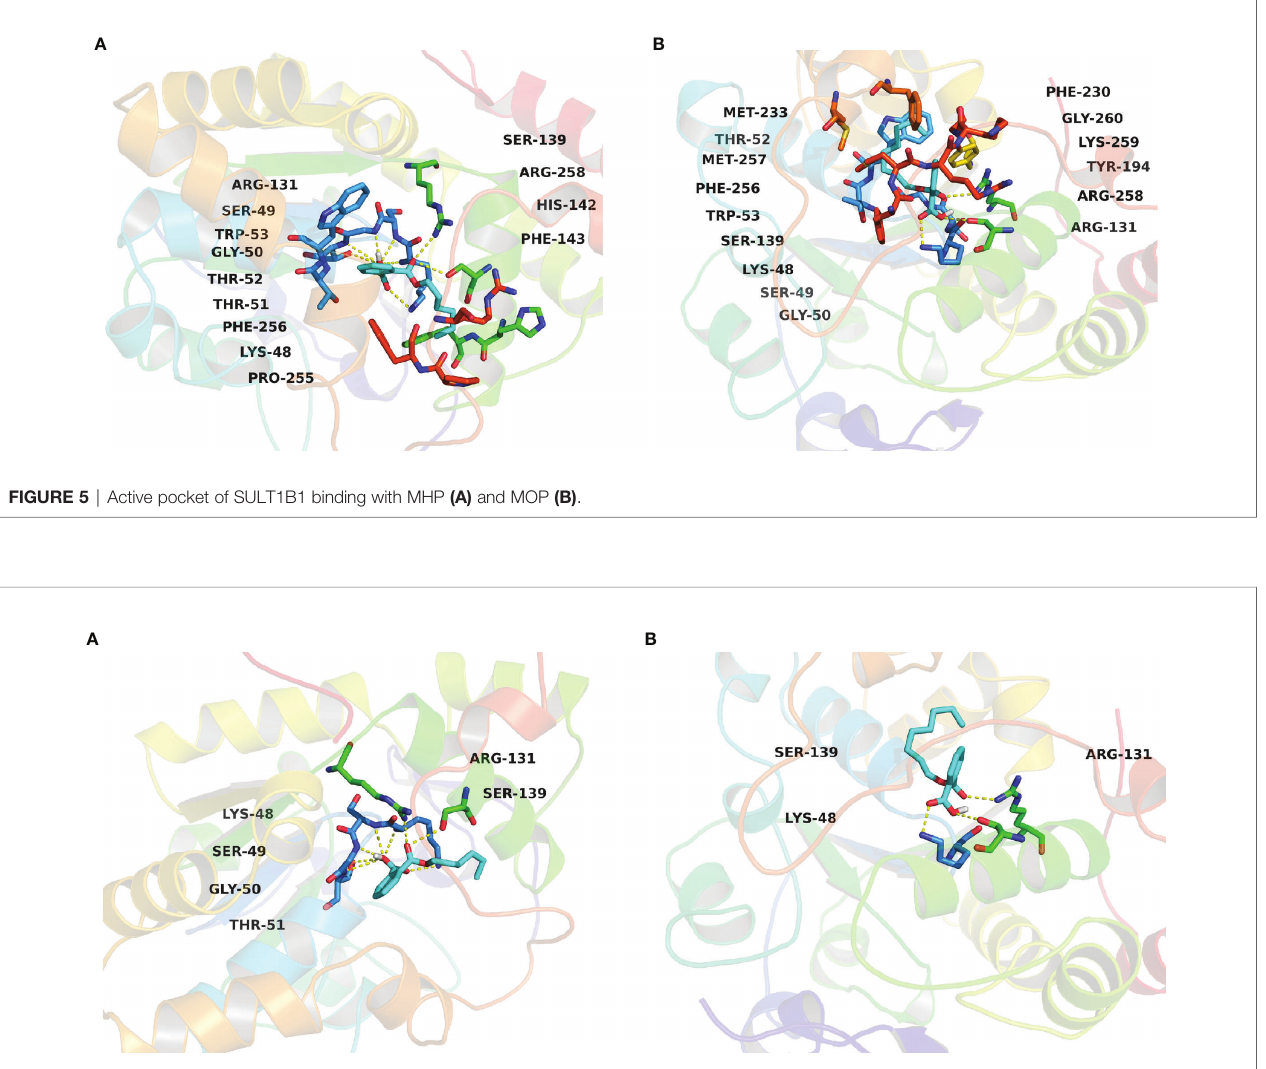
FIGURE 6 | Hydrogen bonds interaction between MHP (A) and MOP (B) with the active cavity of